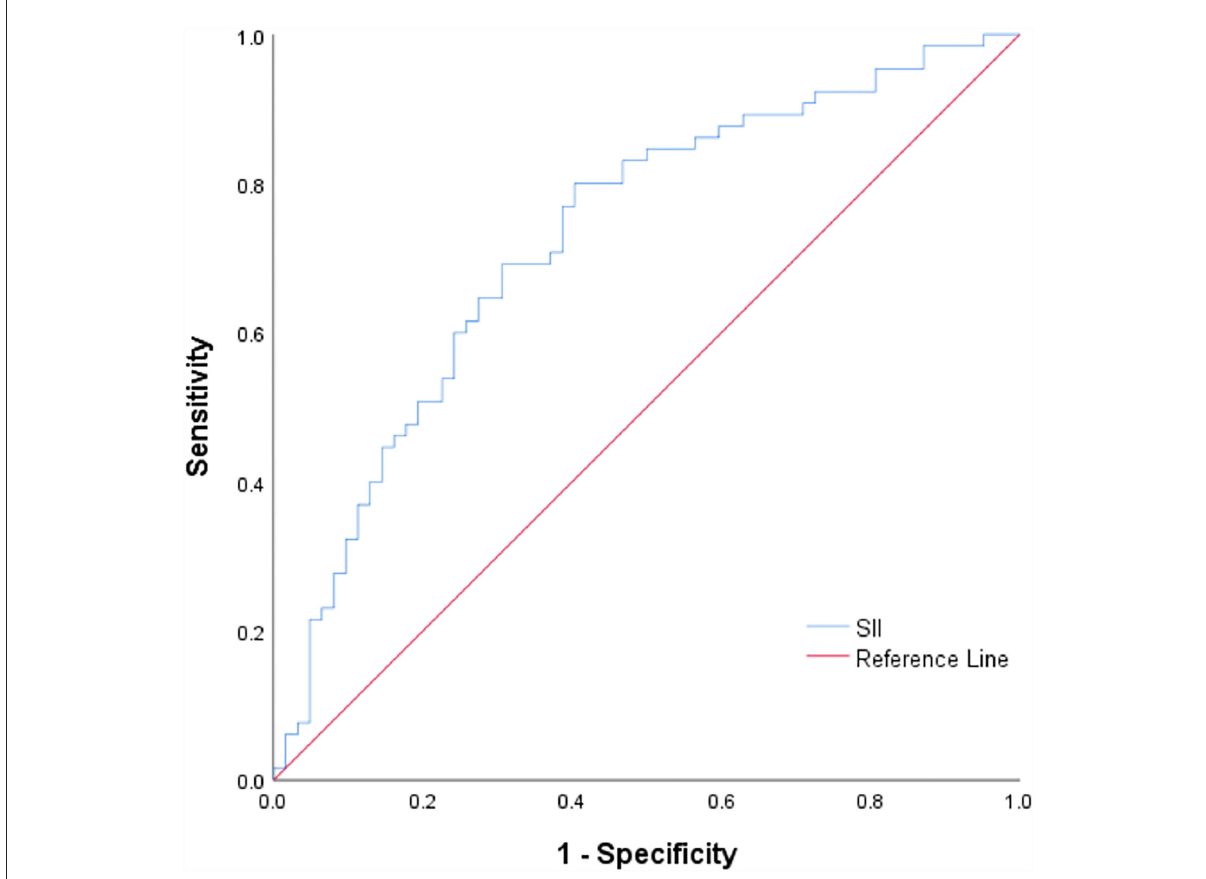
FIGURE3 ROC curve for the SII values to predict plaque vulnerability. ROC, receiving operating characteristic curves; SII, Systemic immune-inflammation index.